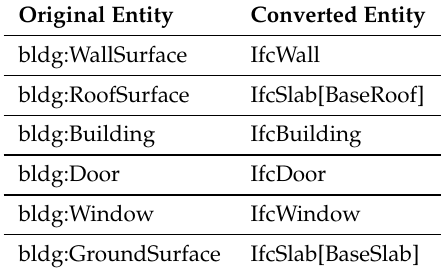
Table 14. Mapping of the CityGML entities to the IFC entities in the conversion of the BuildingLoD3